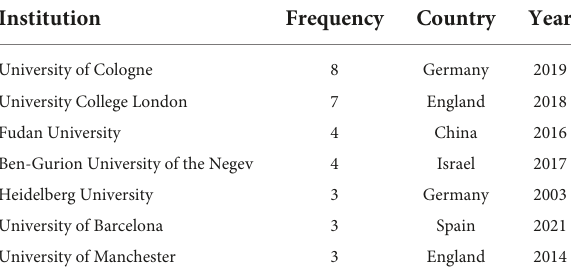
TABLE 2 The top seven institutions for